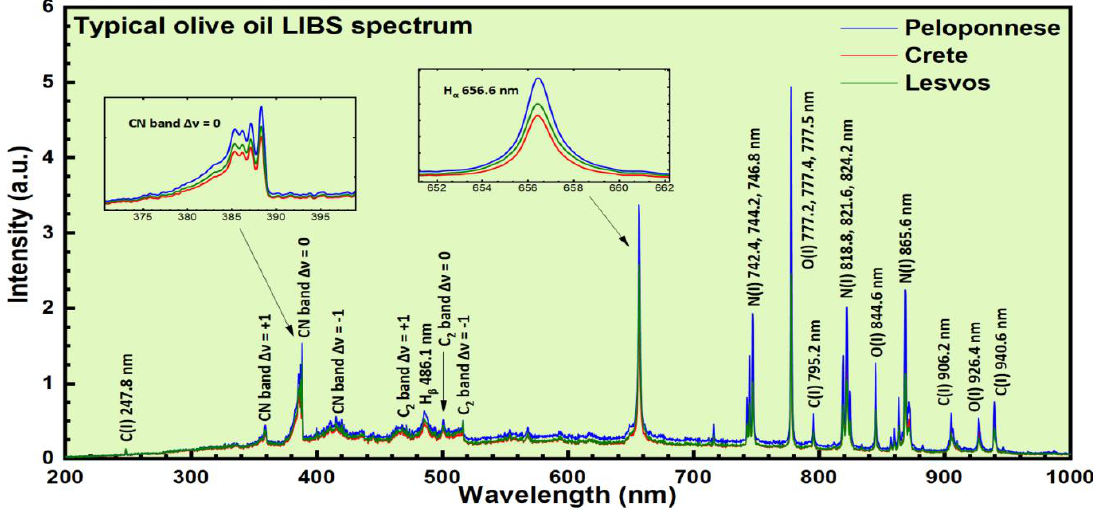
Figure 1. Some characteristic LIBS spectra of olive oils.